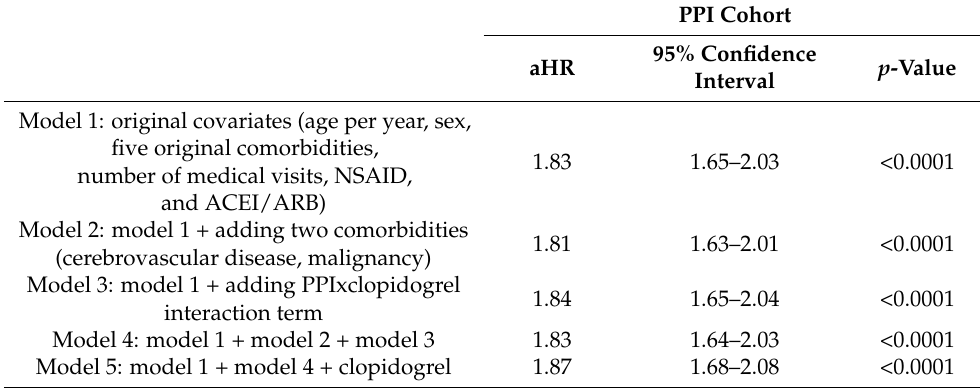
Table 3. Compare the risk magnitude of overall mortality across different regression models in the PPI